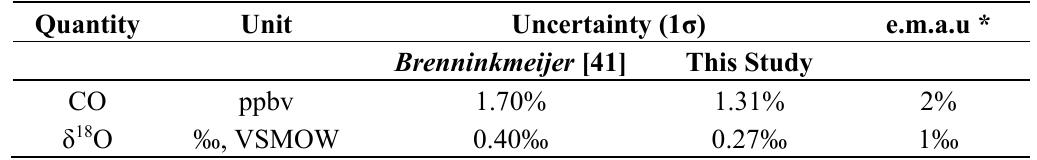
Table 2. Estimated and measured uncertainties in isotopic and concentration